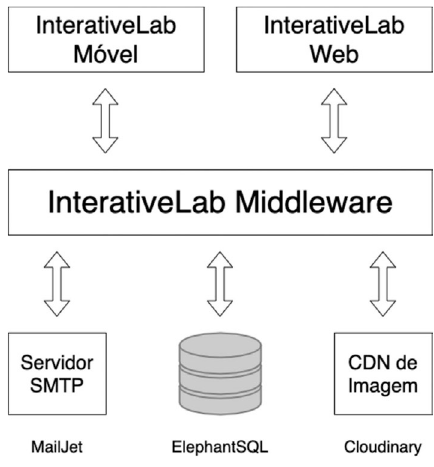
Figure 2 - Client-server architecture applied to